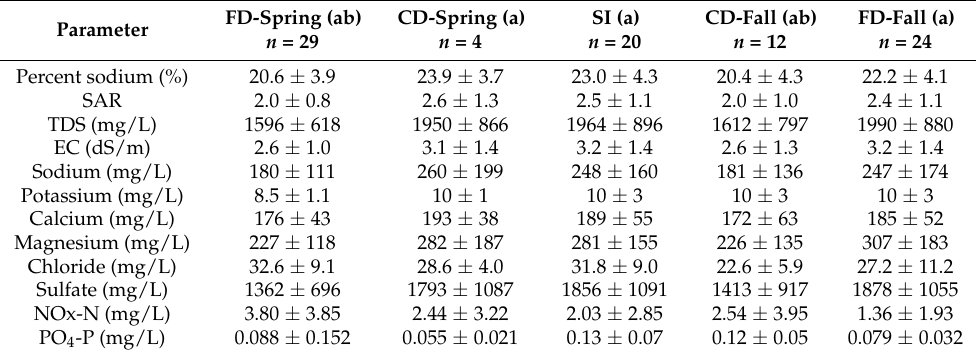
Table 3. Upstream ditch water mean values for percent sodium, sodium adsorption ratio (SAR), total dissolved solids (TDS), electrical conductivity (EC), and chemical concentrations for sodium, potas- sium, calcium, magnesium, chloride, sulfate, nitrite + nitrate nitrogen NOx-N, and orthophosphate (PO 4 -P) in 2012–2018 during free drainage (FD), controlled drainage (CD), and subirrigation (SI) periods. Significant differences as determined by Tukey’s honestly significant difference post hoc test with an alpha value of 0.05 are shown by different letters. Sample size ( n ) is given below each column title and standard deviations are listed for each value.